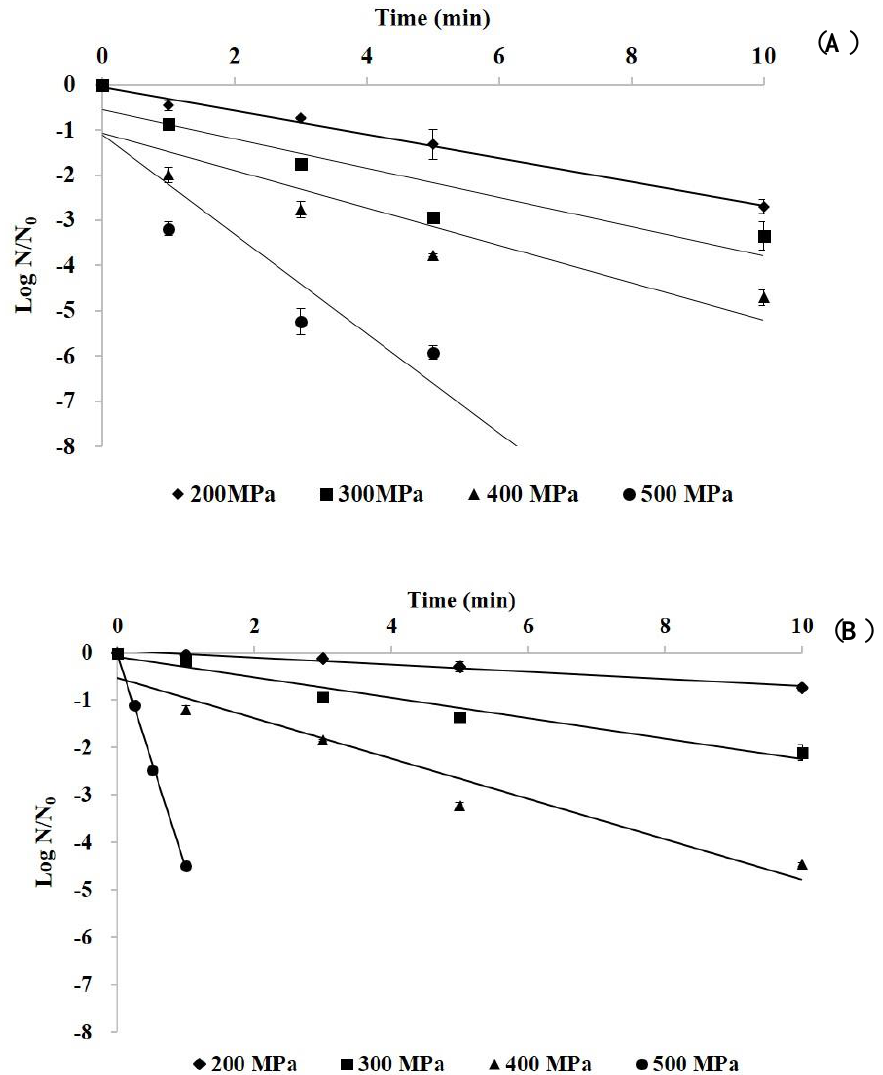
Figure 1. The survival curves of E. aerogenes ( A ) and S. capitis ( B ) in phosphate buffer by high hydrostatic pressure (HHP) treatment at 200–500 MPa for up to 10 min.